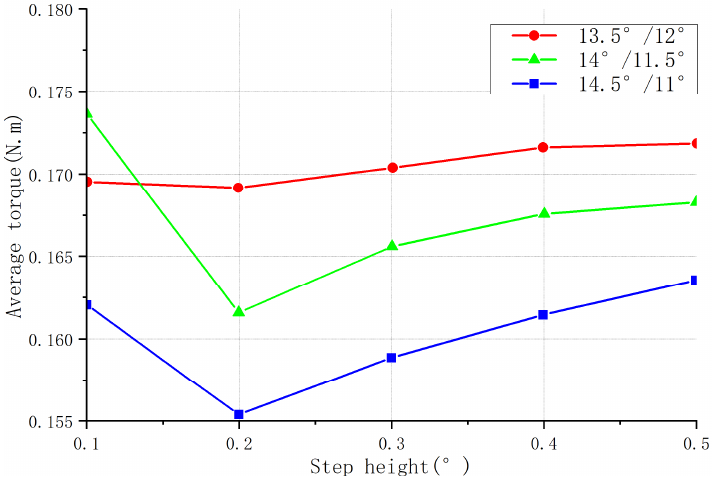
Figure 9. Average torque of different step heights for three parameter combinations.